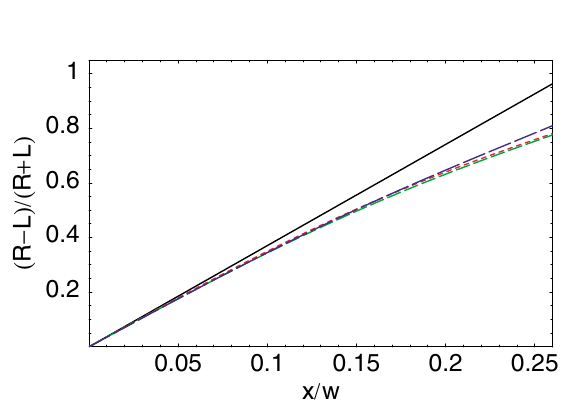
=b (cid:3) 0 : 1 , (cid:7) =b (cid:3) 0 : 2 for three x y FIG. 8. (Color) Same as Fig. 7, but with (cid:7)